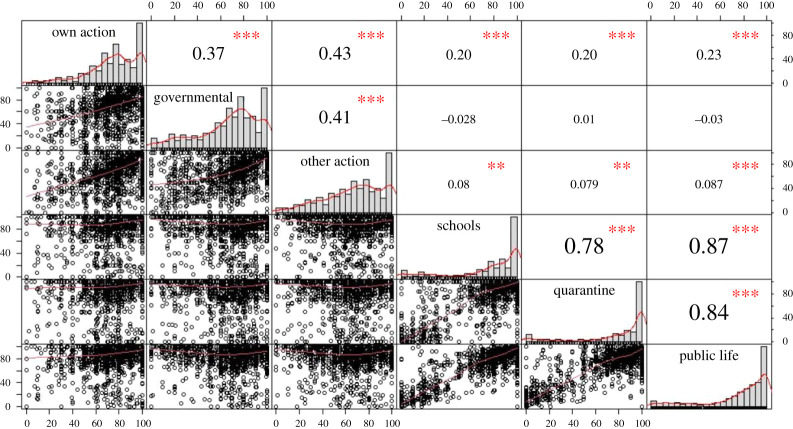
Correlation plot for the perceived efficacy of own, others' or governmental reactions and efficacy of restrictions such as school closings, quarantine and public life restrictions (for a split by country, see electronic supplementary material, figure S2).